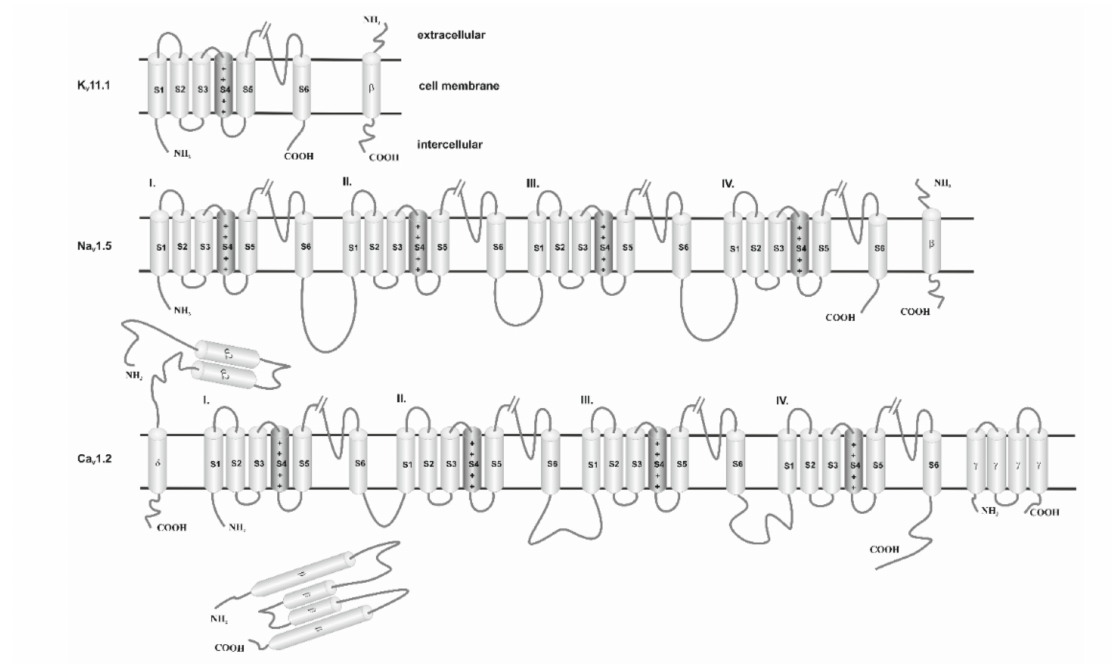
Figure 2. Schematic view of the structure’s subunits of cardiac ion channels. α 1 − subunits of K +